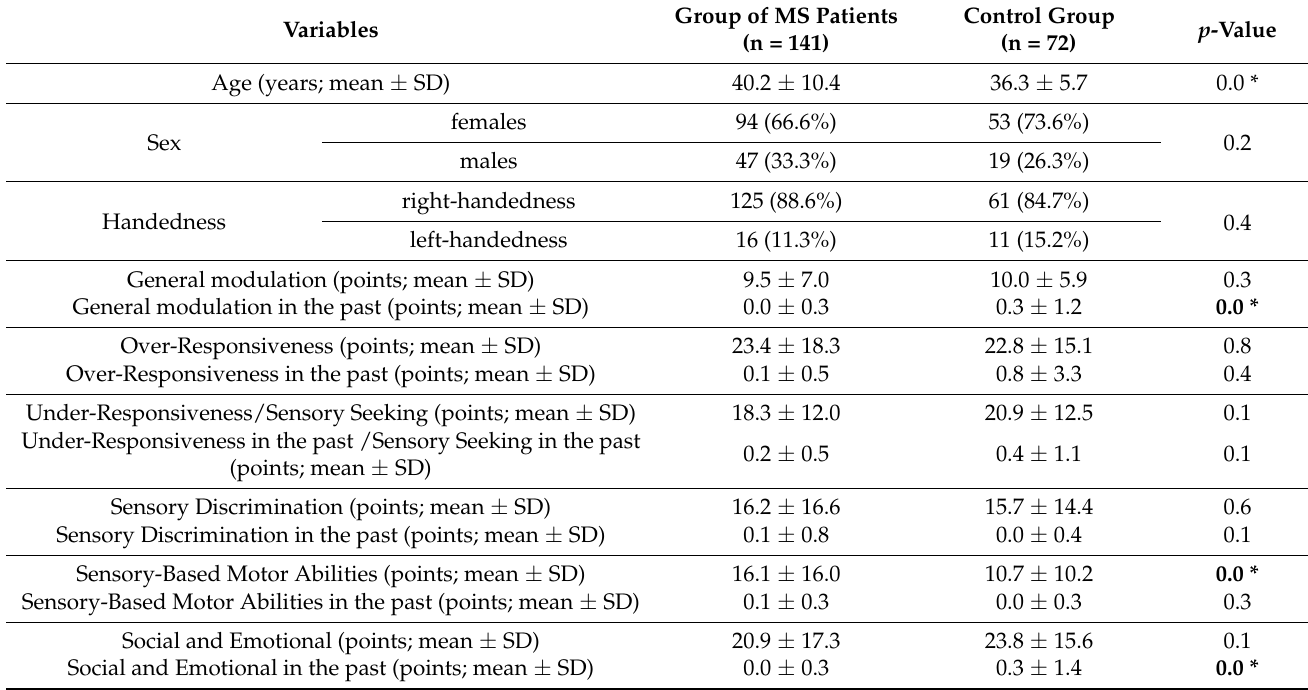
Table 4. The differences in the degree of intensification of sensory integration disorders between patients with MS and healthy subjects (control